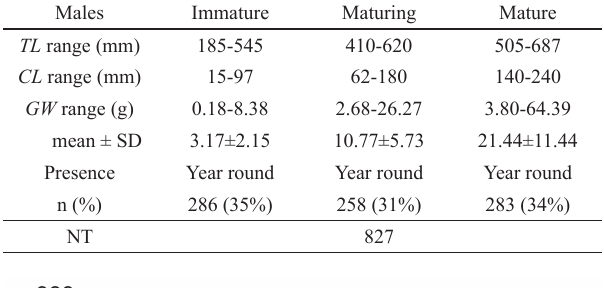
Fig. 4. Size at maturity (TL from San Matías Gulf (Argentina). Males (●): TL 545 mm; R 2 = 0.99; n = 825. Females (○): TL mm; R 2 = 0.98; n = 1,268.